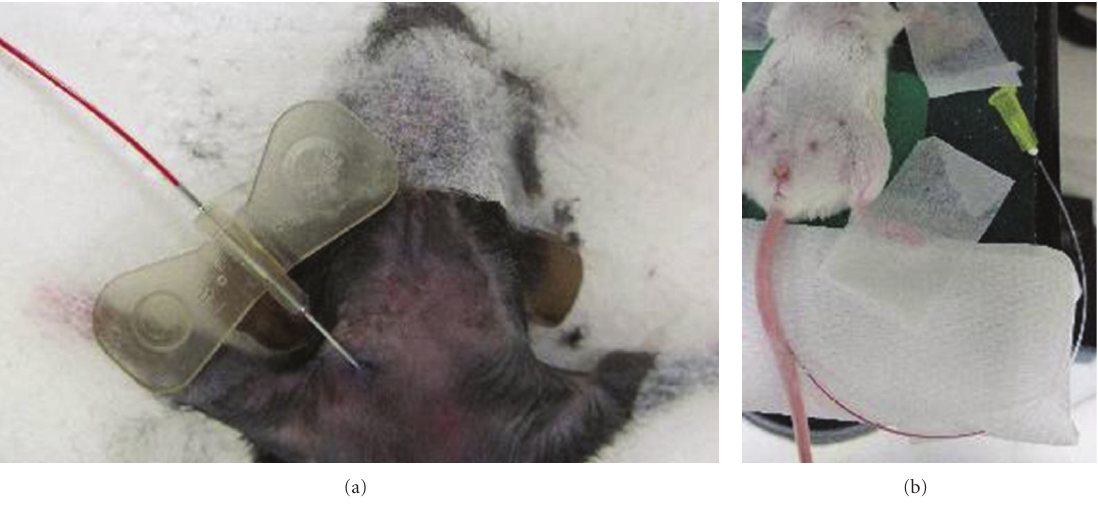
Figure 6: Cannulation of jugular and tail veins. The anesthetized mouse is immobilized by taping its harms on a termoregulated pad. A side of the neck or the tail of the mouse are disinfected. A 27-gauge needle connected by polyethylene tubing (PE10) to a 1mL saline-filled cannula is inserted into the jugular vein or in the lateral tail vein approximately 2 cm from the body. The cannula, filled with heparin solution (750 units/mL in water), is inserted into the vein in caudal direction and fixed to the vein with cyanoacrylate glue (Histoacryl, B Braun, Am Aesculap-Platz, Germany). The proof of the correct position of the needle is given by blood visualization in the cannula. (a) Cannulation of jugular vein. (b) Cannulation of lateral tail vein.